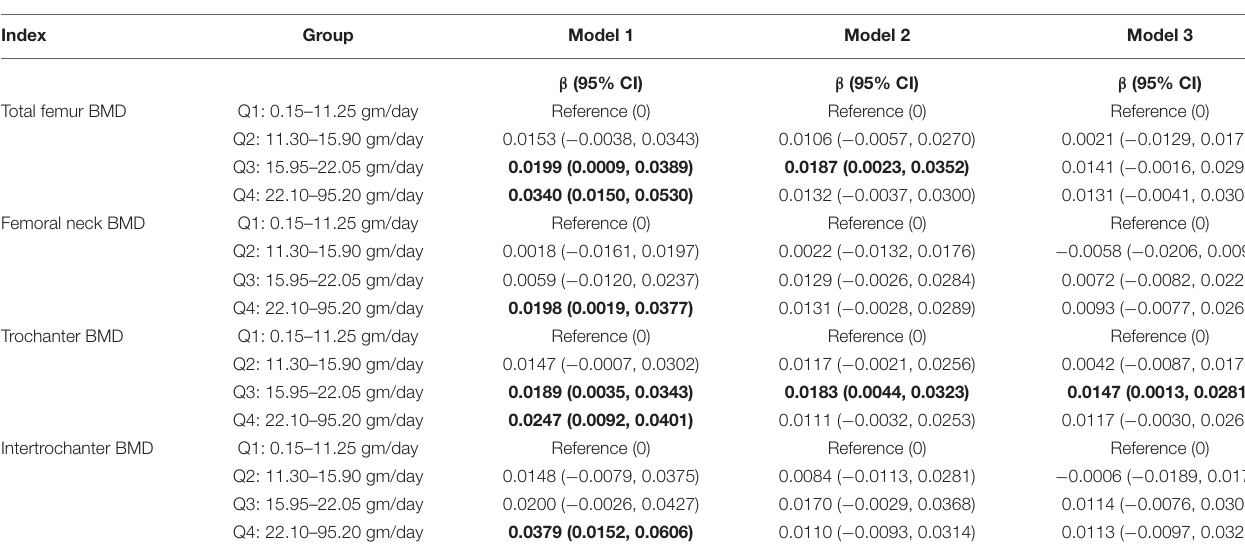
TABLE 3 | Association between dietary fiber intake and femoral BMD.